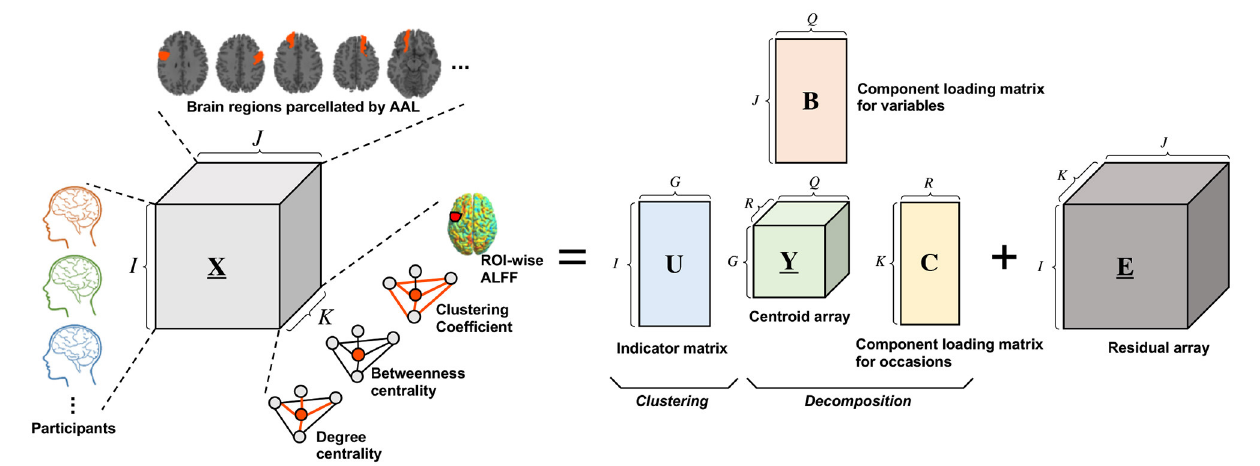
FIGURE 2 | Schematic illustration of Tucker3 clustering on functional neuroimaging data. X( I × J × K ), Y( G × Q × R ) and E( I × J × K ) denote the three-way data array of observation data, the centroid array, and the residual array, respectively. U( I × G ), B( J × Q ), and C( K × R ) denote the indicator matrix defining a partition of the objects into G classes, the component loading matrix for variables, and the component loading matrix for occasions, respectively.